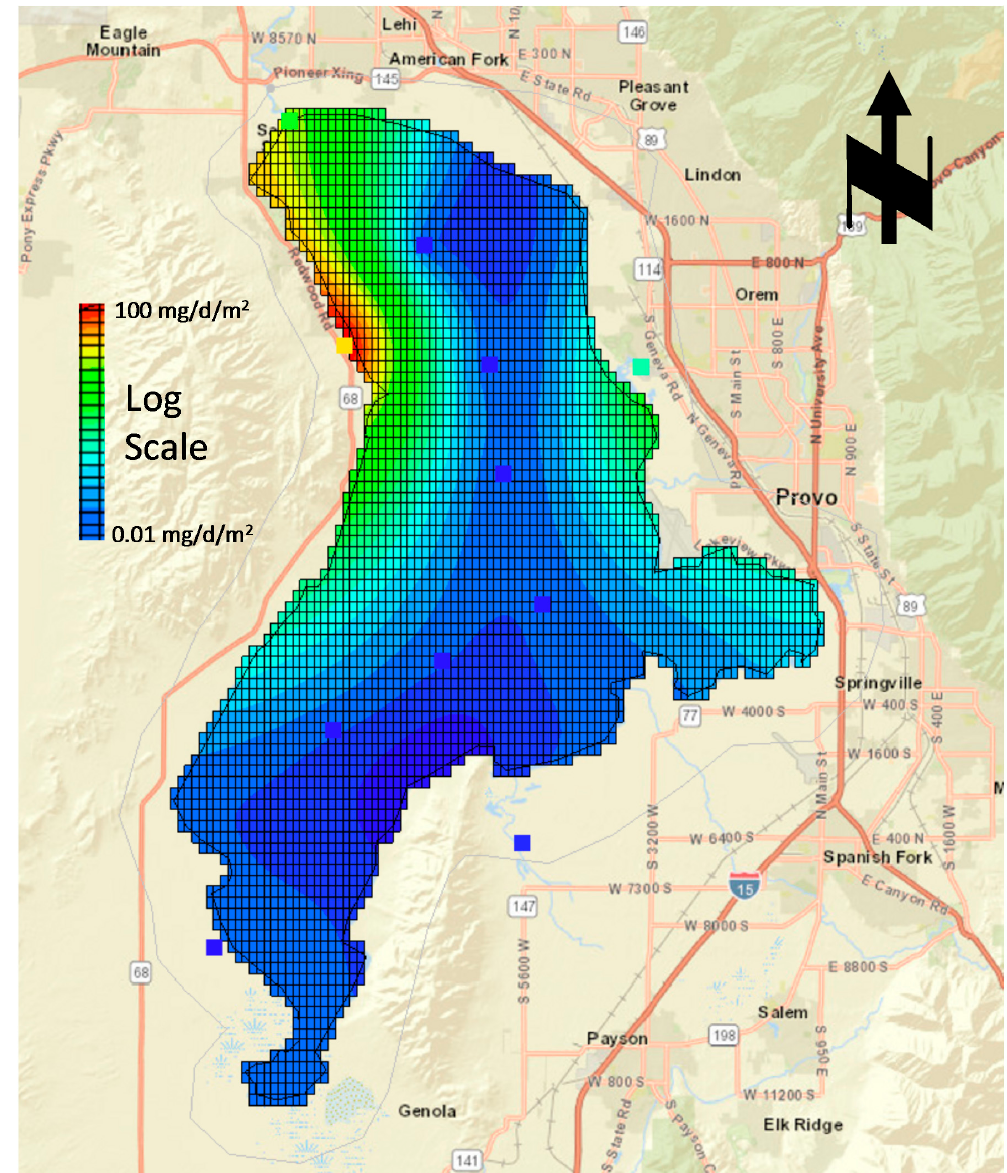
Figure 10. Example map showing the spatial deposition rates for TP for the period of 4 May 2017 through 11 May 2017. The map shows that the pseudo sample sites in the center of the lake, which represent regional background rates, strongly influence the distribution. The colors are on a logarithmic scale with red approximately 100 mg m − 2 day − 1 and blue about 0.01 mg m − 2 day − 1 spanning four orders of magnitude. This map shows that the influence of high values at shoreline stations do not reach significantly into the lake because of the small variogram range used for kriging.